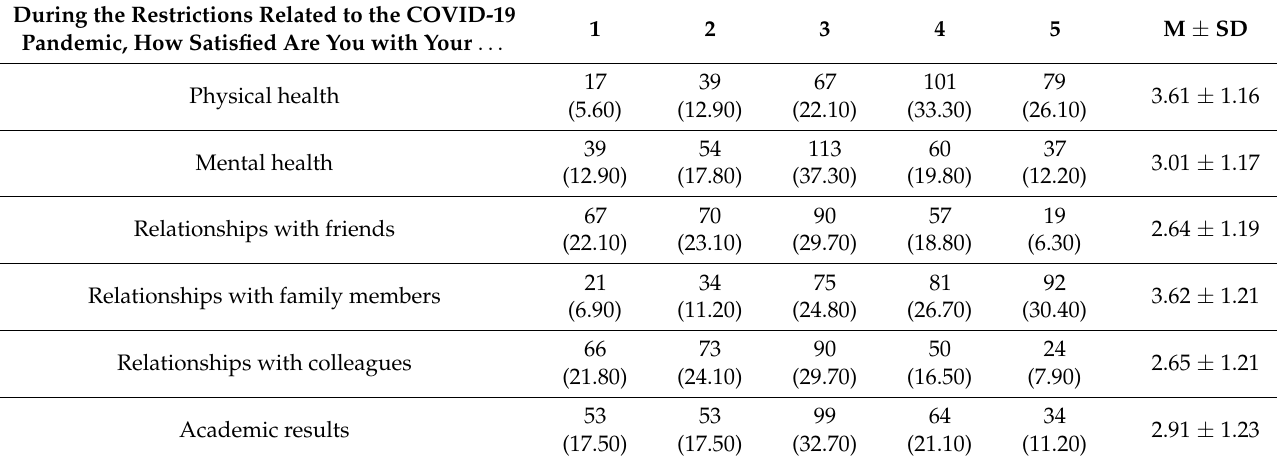
Table 3. Satisfaction regarding relationships with family, friends, and colleagues and academic results 1 . During the Restrictions Related to the COVID-19 Pandemic, How Satisfied Are You with Your . .